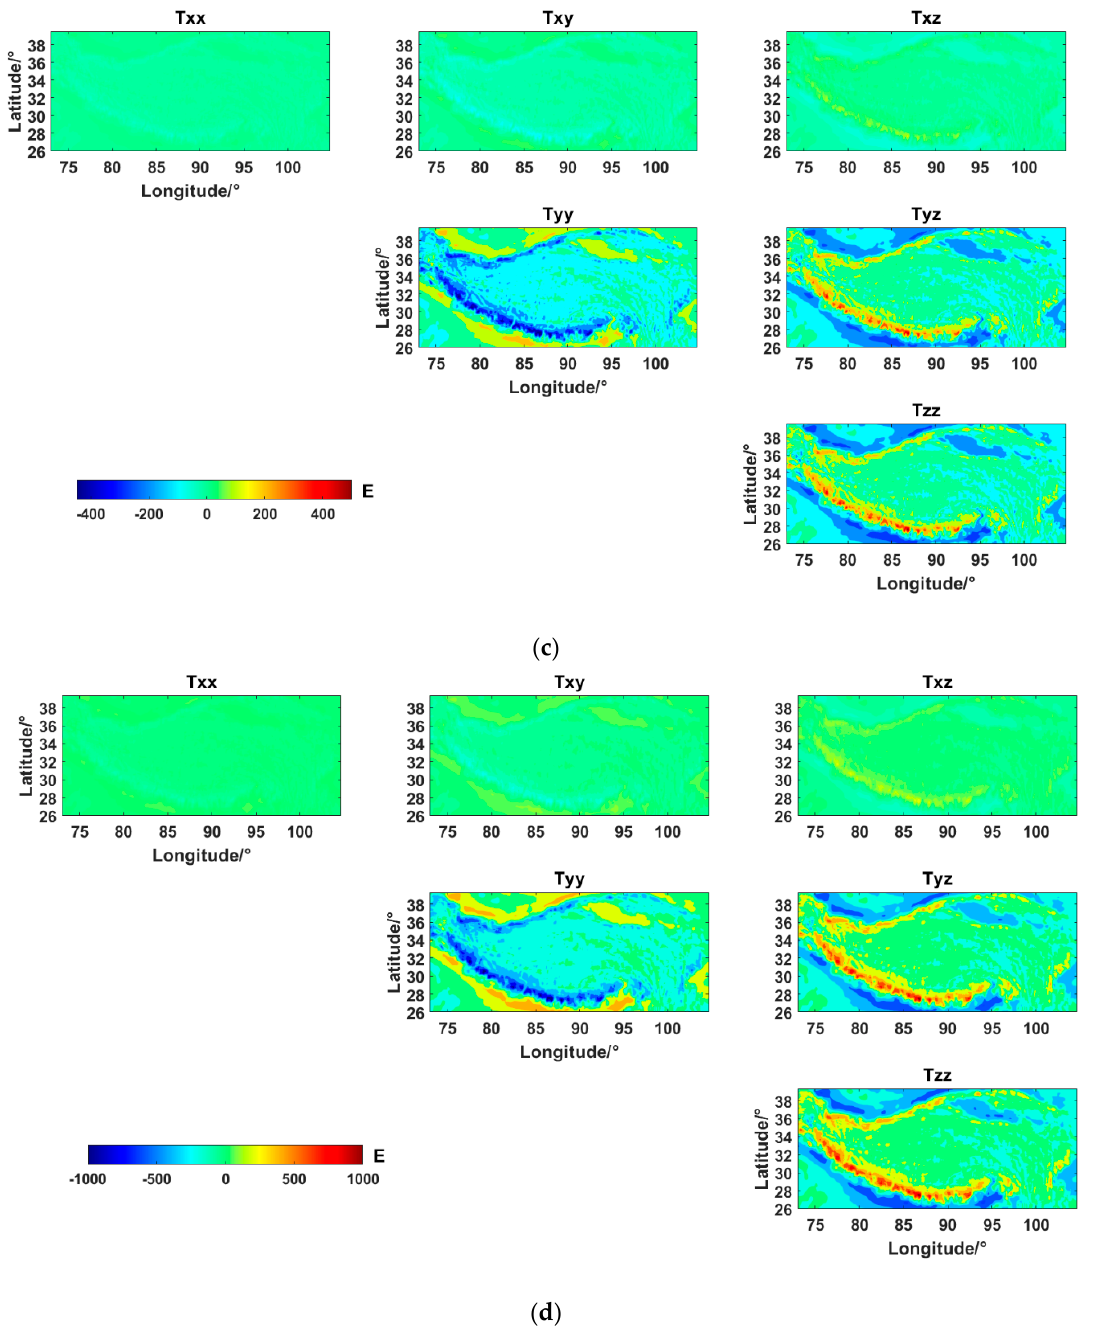
Figure 4. Diagram of inversion results from the Qinghai–Tibetan Plateau: ( a ) 5 × 10 truncation